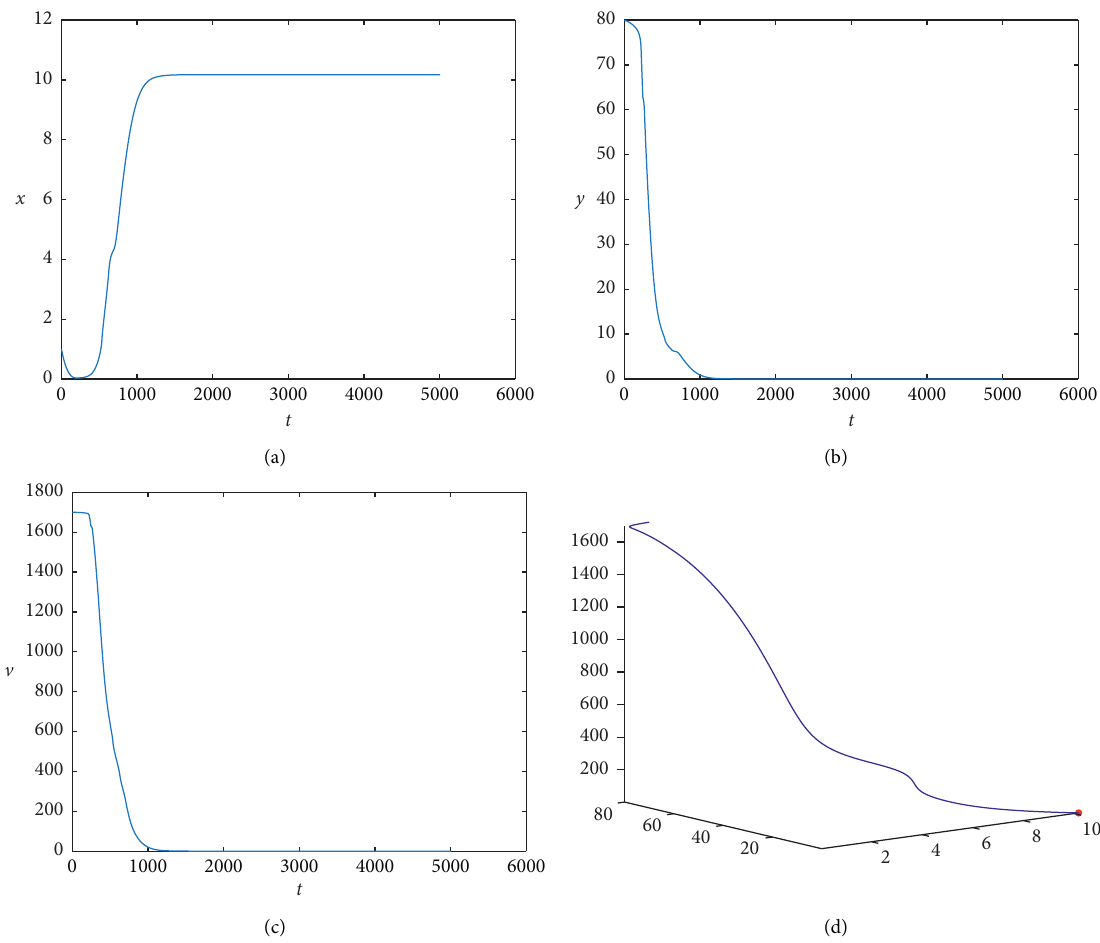
Figure 1: Illustration of basic behavior of solutions of system (4) with initial condition I (b) time series of y ( t ), (c) time series of v ( t ), and (d) phase trajectories of x ( t ), y ( t ), and v ( t